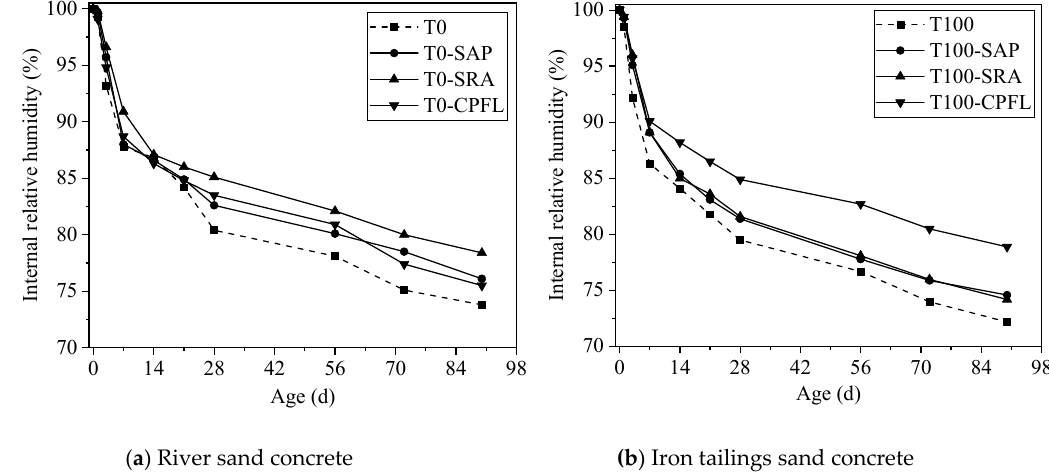
Figure 11. Development of internal RH of different concrete under drying shrinkage.